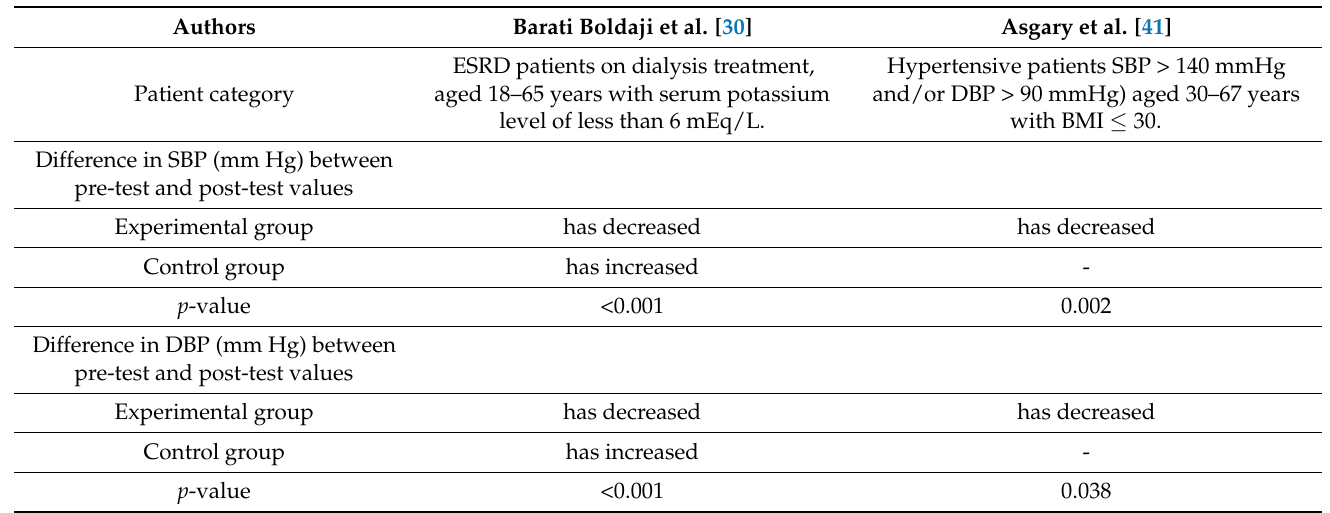
Table 3. The difference in SBP (mm Hg) and DBP (mm Hg) between pre-test and post-test values.